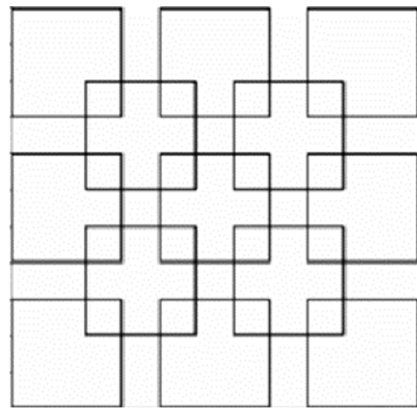
Figure 3. Geometric model.